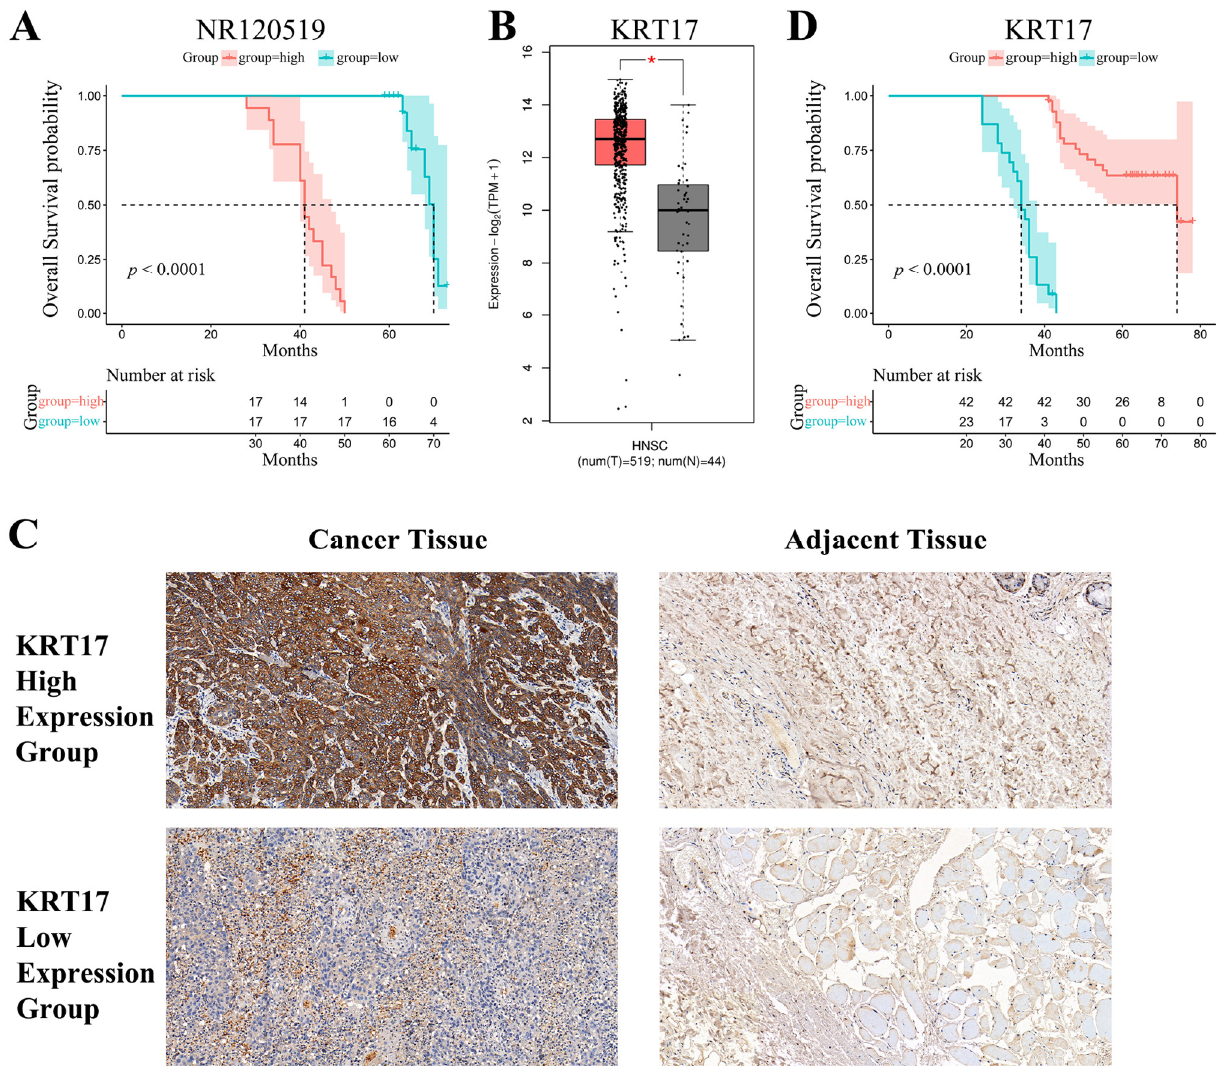
Figure 10. High expression of NR120519 and KRT17 denoted worse and better prognosis, respectively. ( A ) Kaplan–Meier survival analysis using relative Ct values of NR120519 from 35 fresh tissues of hypopharyngeal cancer. ( B ) The relative expression of KRT17 in head and neck malignancies versus paraneoplastic tissues was analyzed using the GEPIA database. ( C ) Immunohistochemical assay showing the expression of KRT17 in hypopharyngeal carcinoma tissues and paraneoplasms classified into high and low expression groups. Representative images (400 × ) are shown. ( D ) Immunohisto- chemical experiments were performed in 65 hypopharyngeal cancer tissues embedded in wax blocks, which were classified into KRT17 high and low expression groups. Kaplan–Meier survival analysis was performed. * p <